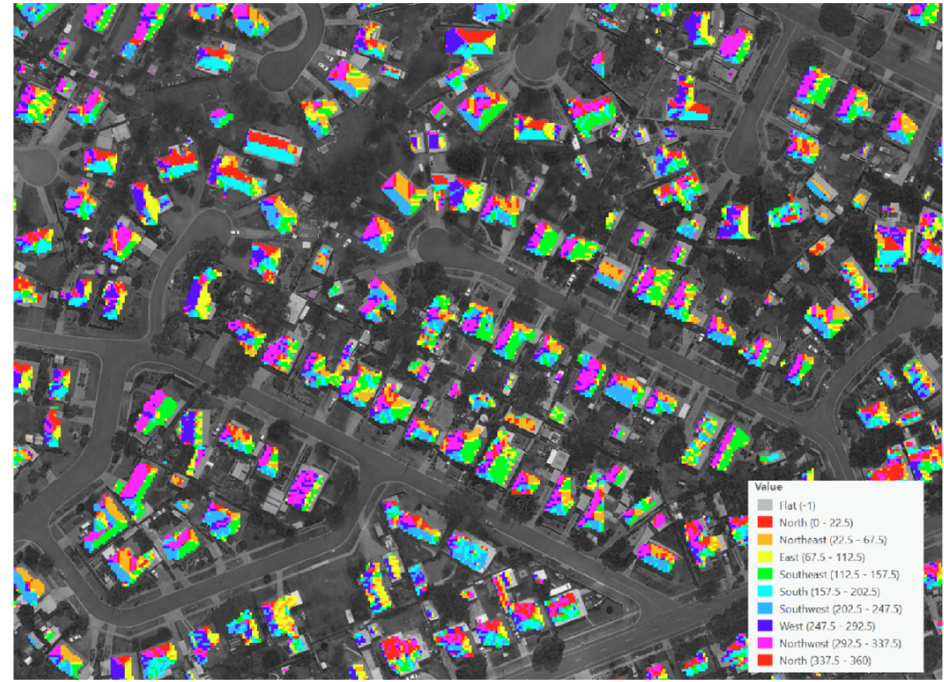
Figure 3. Roof azimuth angle raster layer calculated using BHM and QGIS Aspect function.